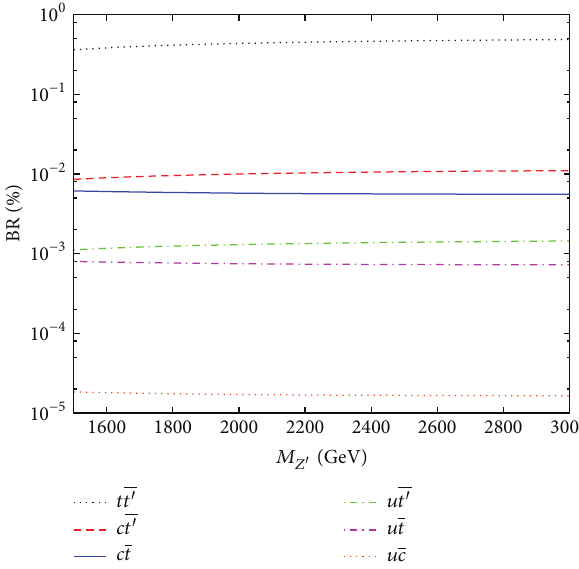
Figure 3: Branching ratios (%) depending on the mass of the 𝑍 󸀠 boson for FCNC couplings to different flavors of up-sector quarks within the 𝑍 󸀠 𝜂 model. Here the mass of 𝑡 󸀠 quark is 700 GeV and the FCNC parameter 𝑥 = 0.1 .